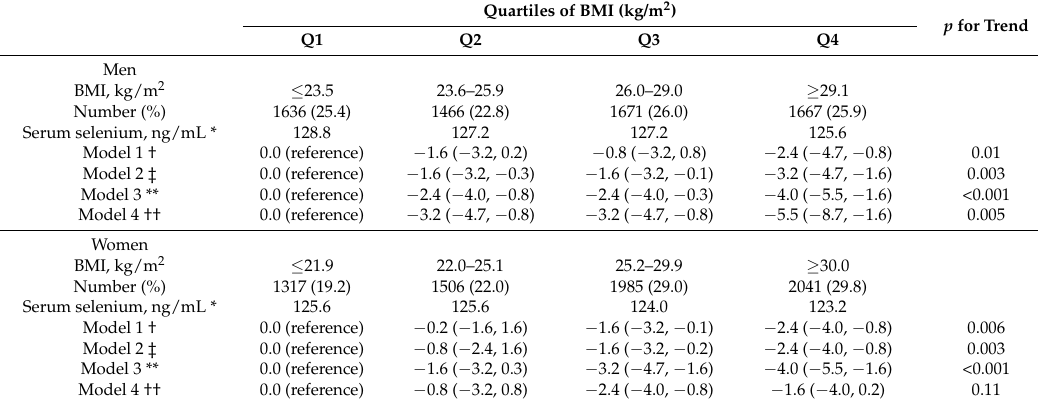
Table 2. Difference (95% confidence interval (CI)) in serum selenium concentrations by quartiles of body mass index